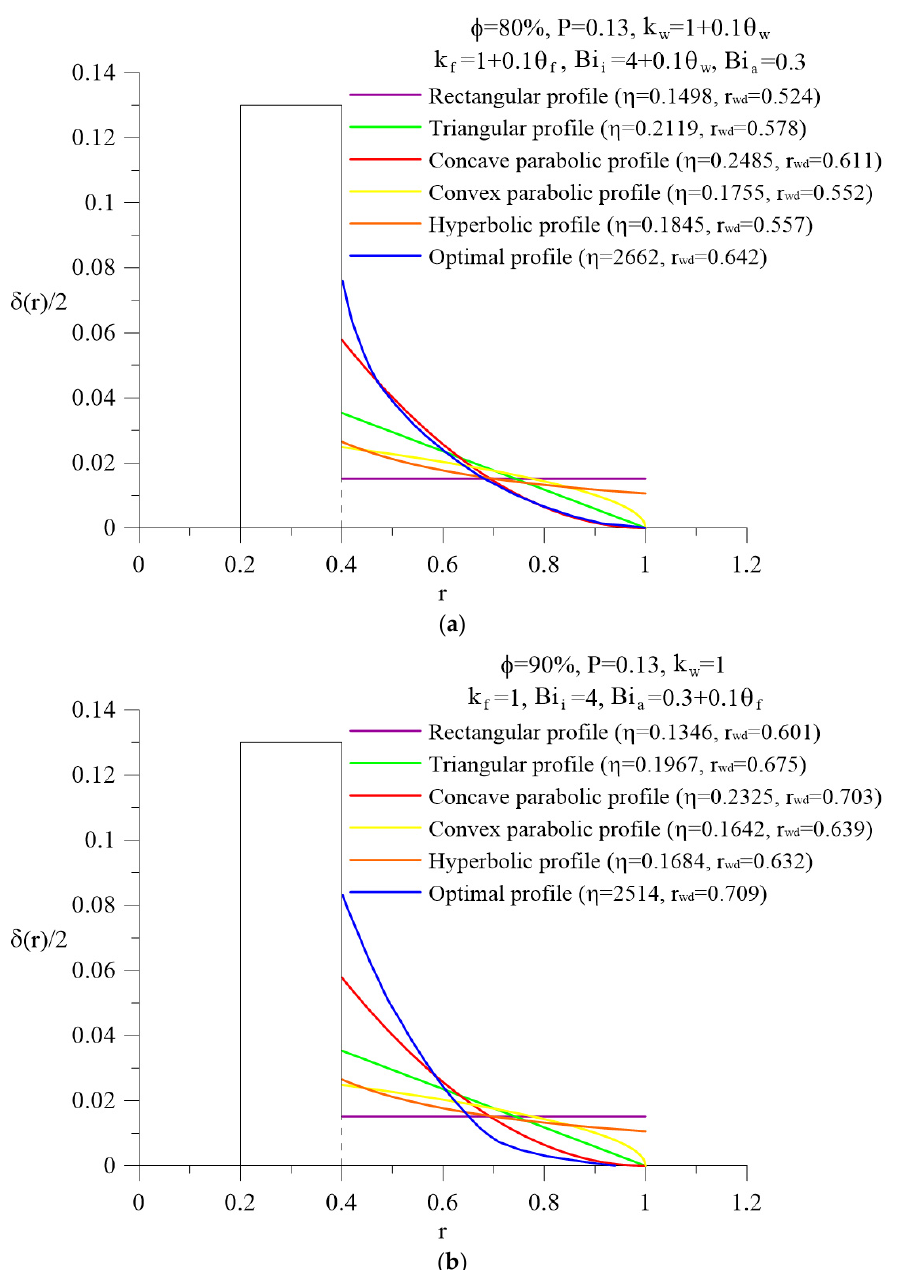
Figure 9. ( a ) The comparisons of fin shapes for different types of partially wet annular fins. ( b ) The comparisons of fin shapes for different types of partially wet annular